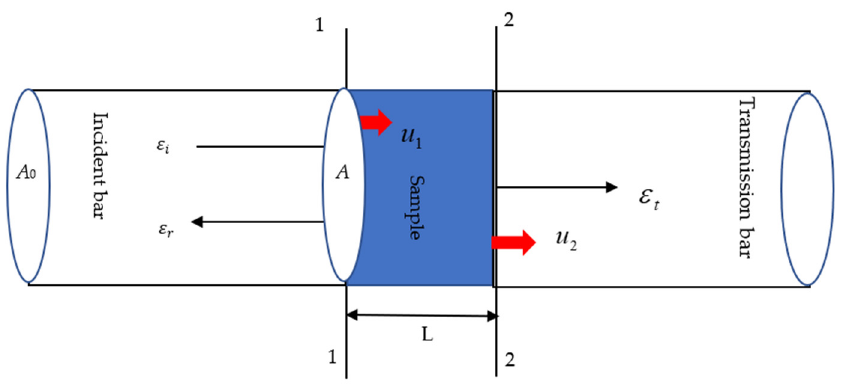
Figure 5. Schematic diagram of rock sample under impact by SHPB adapted from [57]. As illustrated in Figure 3, the cross-sectional area of the incident bar and the trans- mission bar is A 0 , while the cross-sectional area and length of the concrete sample are A and L , respectively. The stress at the interface of 1-1 and interface of 2-2 is σ 1 ( t ) and σ 2 ( t ) , respectively. C 0 and E o indicate the wave velocity and the elastic modulus, respectively, of the incident bar and the transmission bar. ε i and ε r indicate the incident wave and the reflected wave in the incident bar. The transmission wave in the transmission rod is ε t